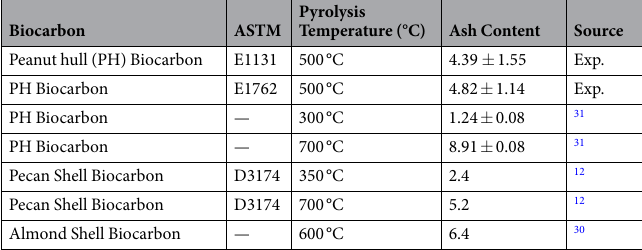
Table 6. Ash content for biocarbon derived from nut shells.